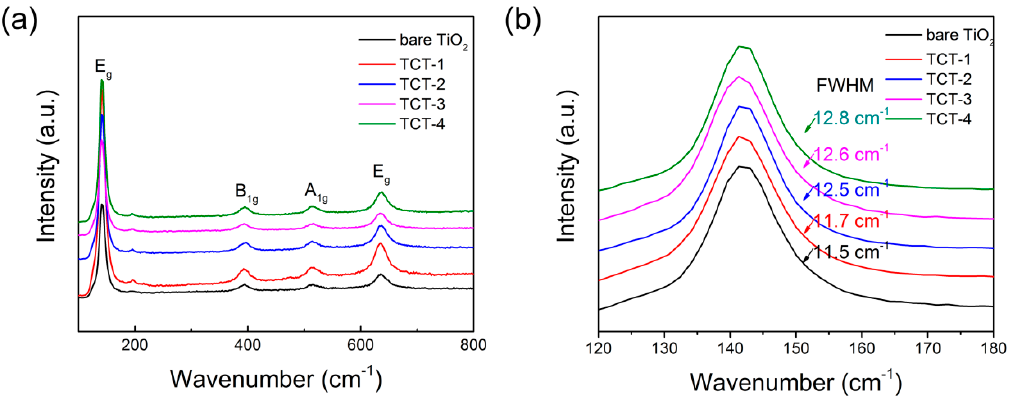
Figure 5. ( a ) Raman spectra of bare TiO 2 and TCT materials; and ( b ) the enlarged Raman spectra at around 144 cm − 1 of all five samples.